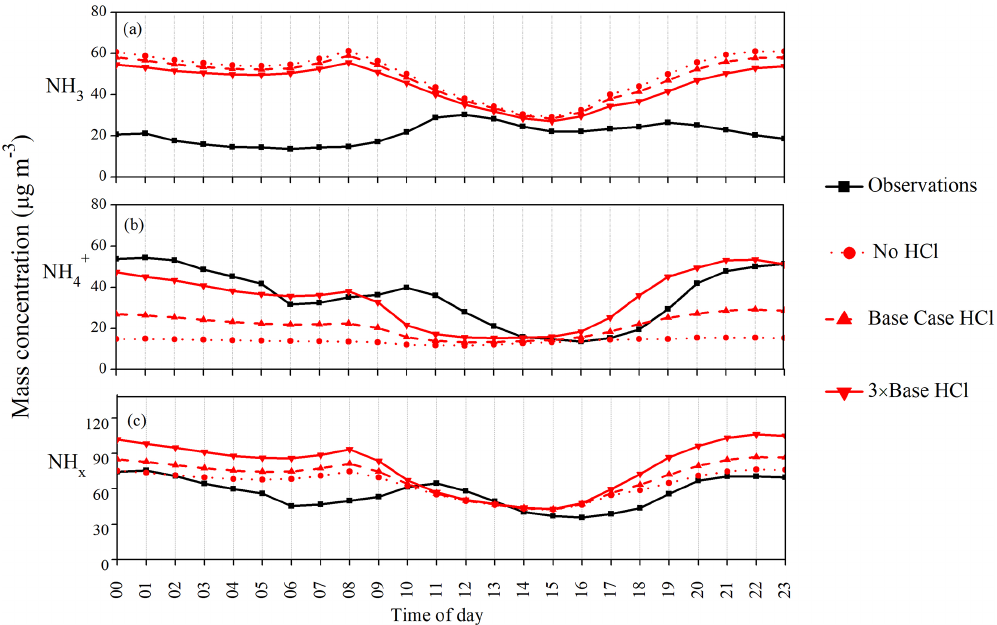
+ concentration and (c) total NH x concentration observed (black), 4 + , and total NH x concentration at IGIA, Delhi, from three sensitivity experiments in no 4